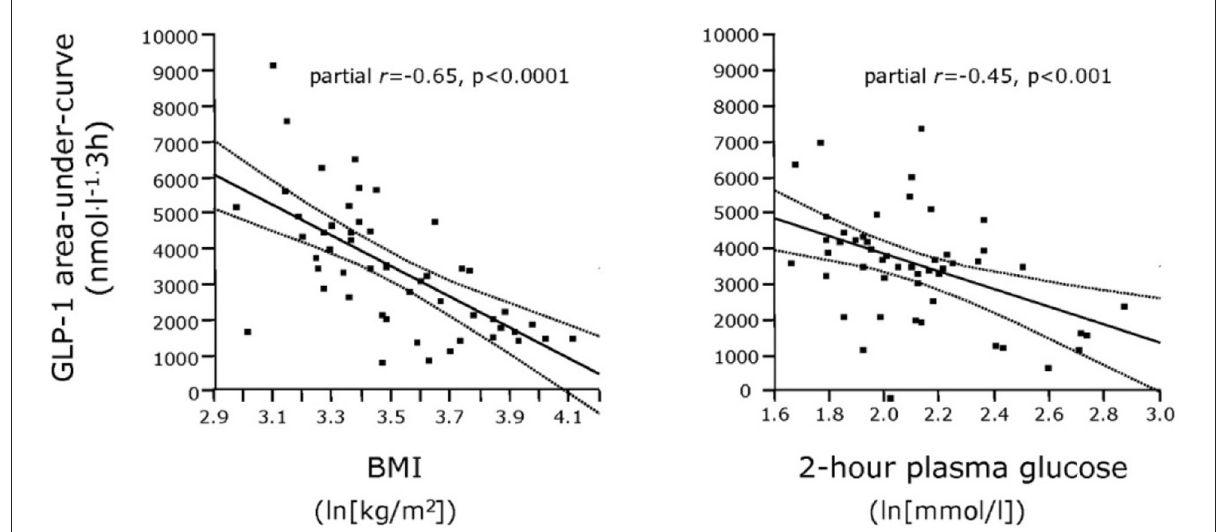
FIGURE3 Relationship between plasma GLP-1 responses (Areas Under Curve) and BMI as well as 2-h plasma glucose concentrations in patients with varying degrees of obesity and T2DM. From Muscelli et al.